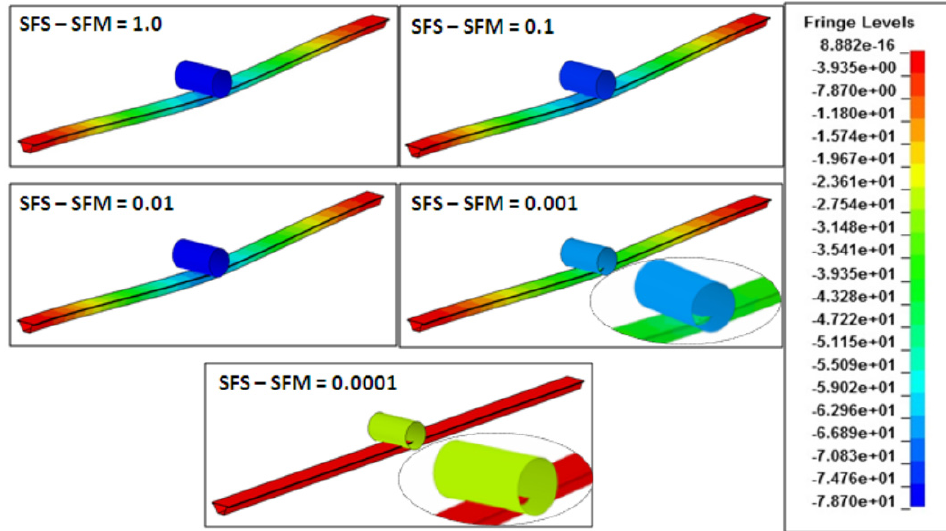
Figure 12. Effect of SFS/SFM values on contact of impactor and stiffened